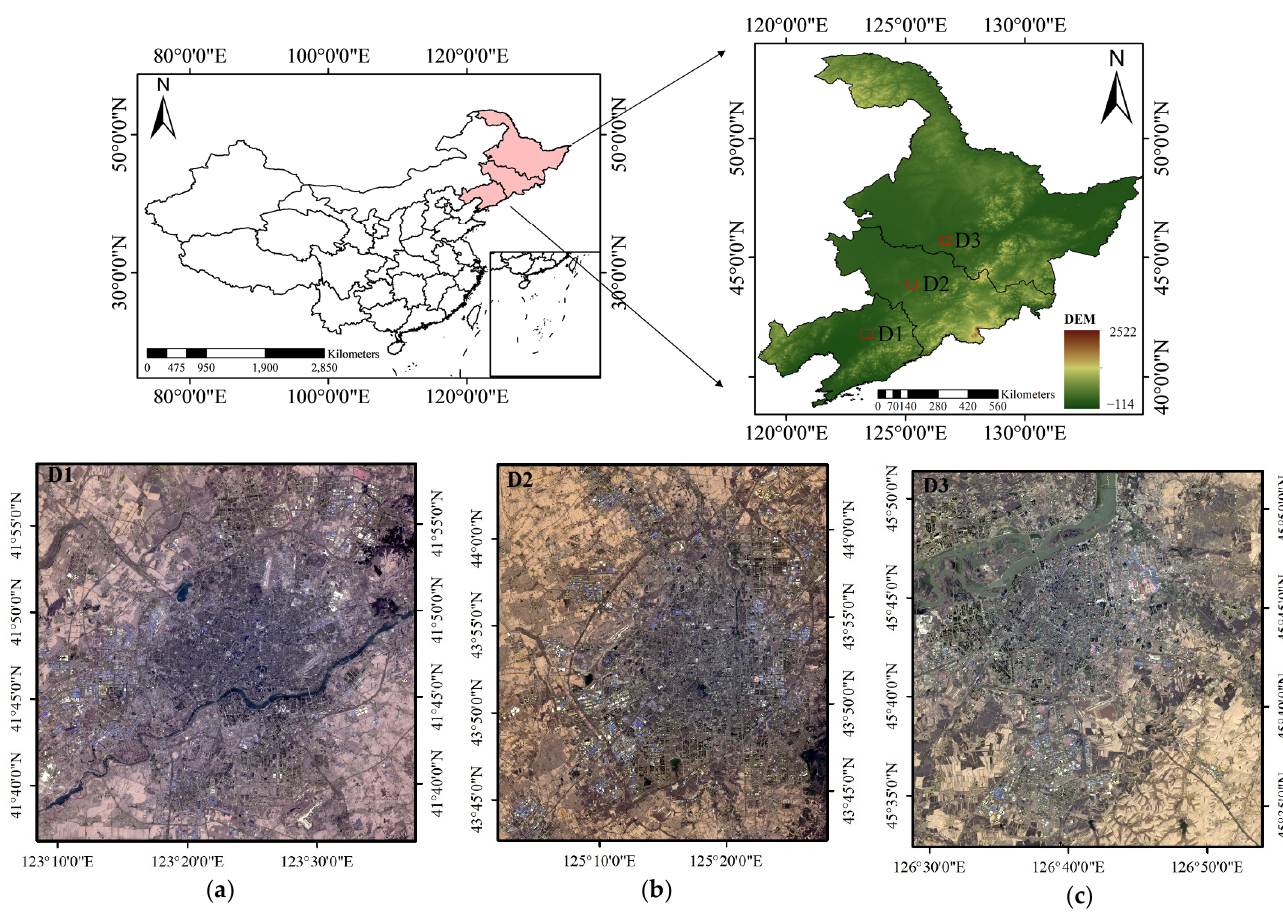
Figure 1. The locations of the study areas, and true color images in November. ( a ) Image of study area 1 (D1); ( b ) Image of study area 2 (D2); ( c ) Image of study area 3 (D3).